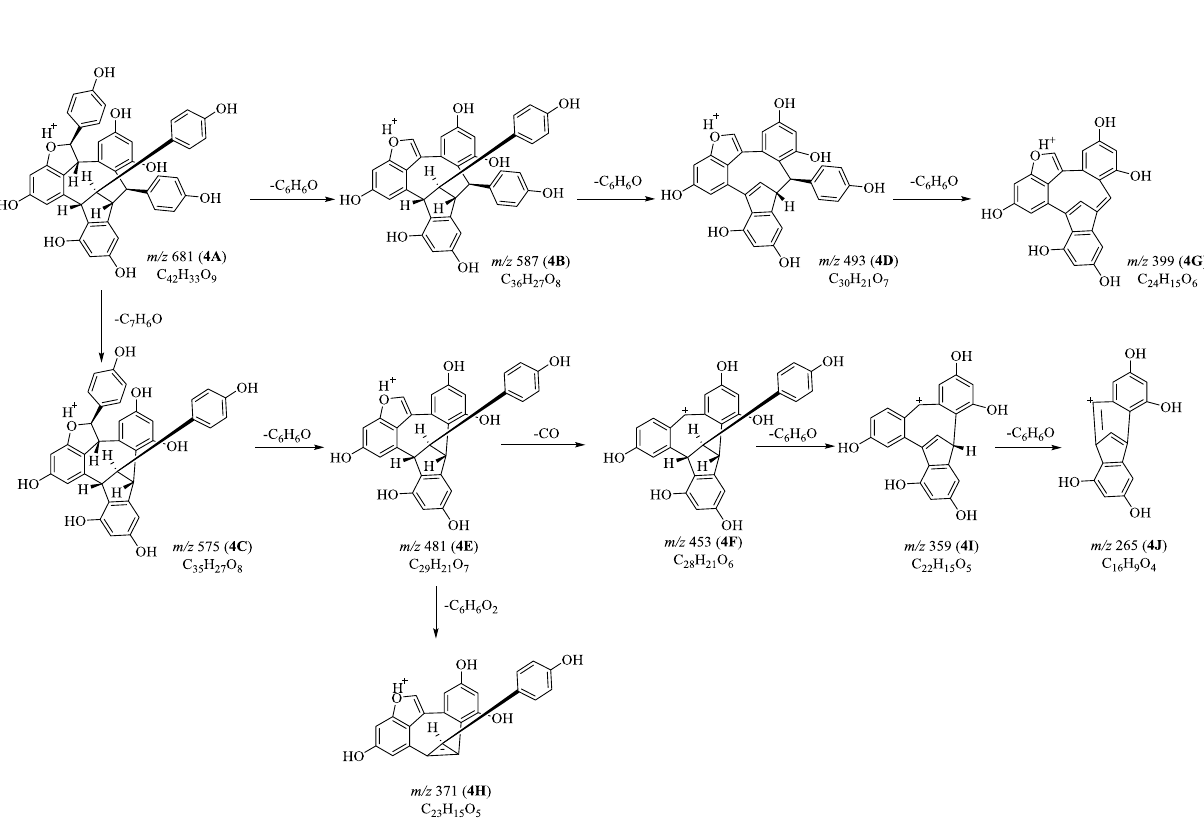
Fig. 8 Proposed fragmentation pathways of suffruticosol C ( 4 ) in positive